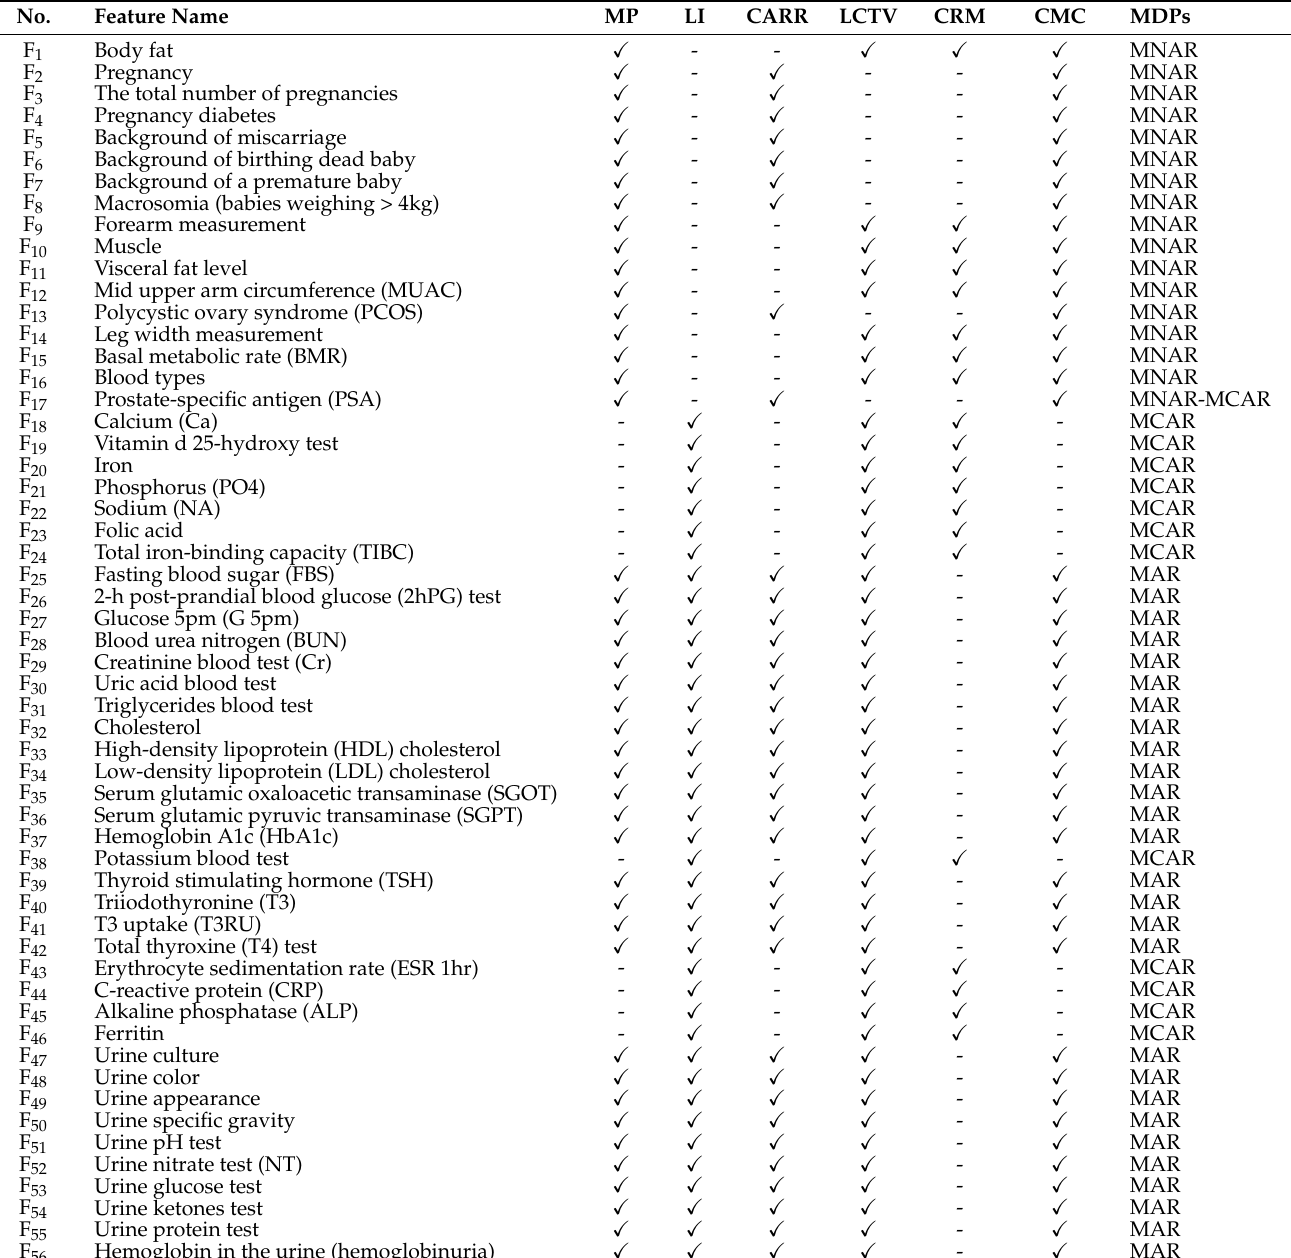
Table 1. Description of the IRDia’s features and their missing data patterns